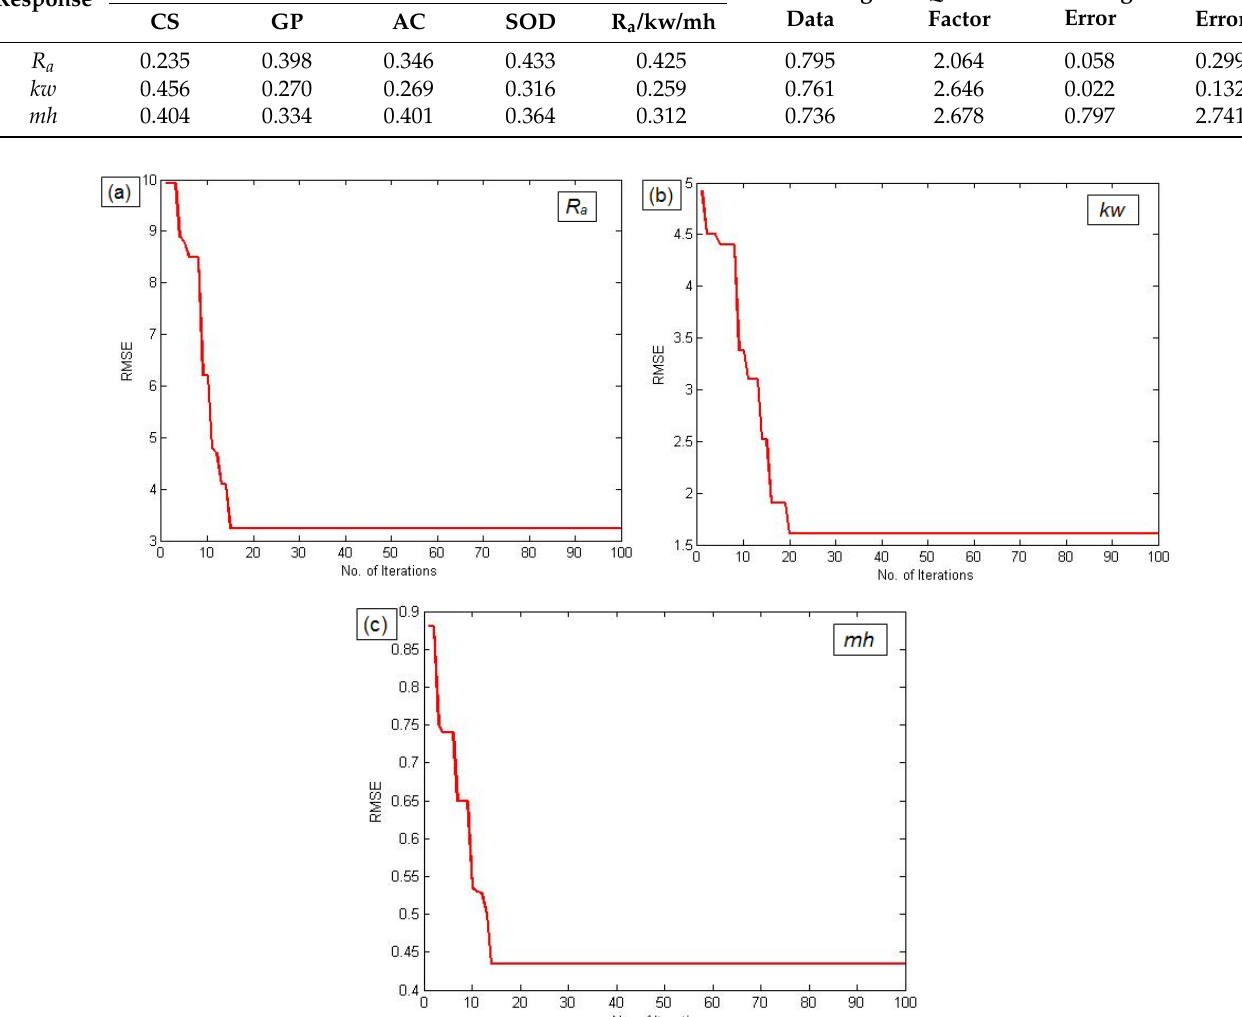
Table 4. GA parameters for optimizing ANFIS network.